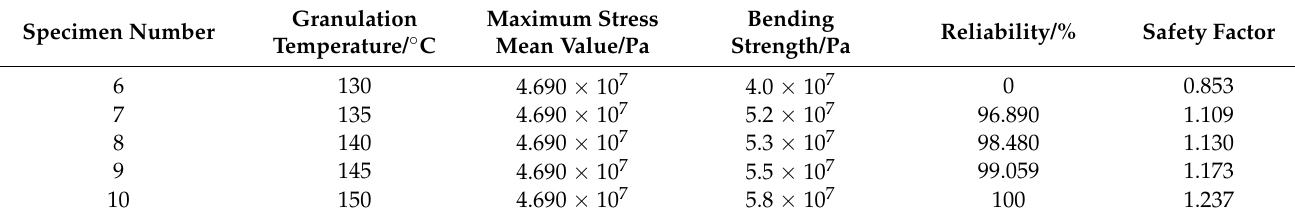
Table 4. Simulation results of the granulation temperature on reliability.